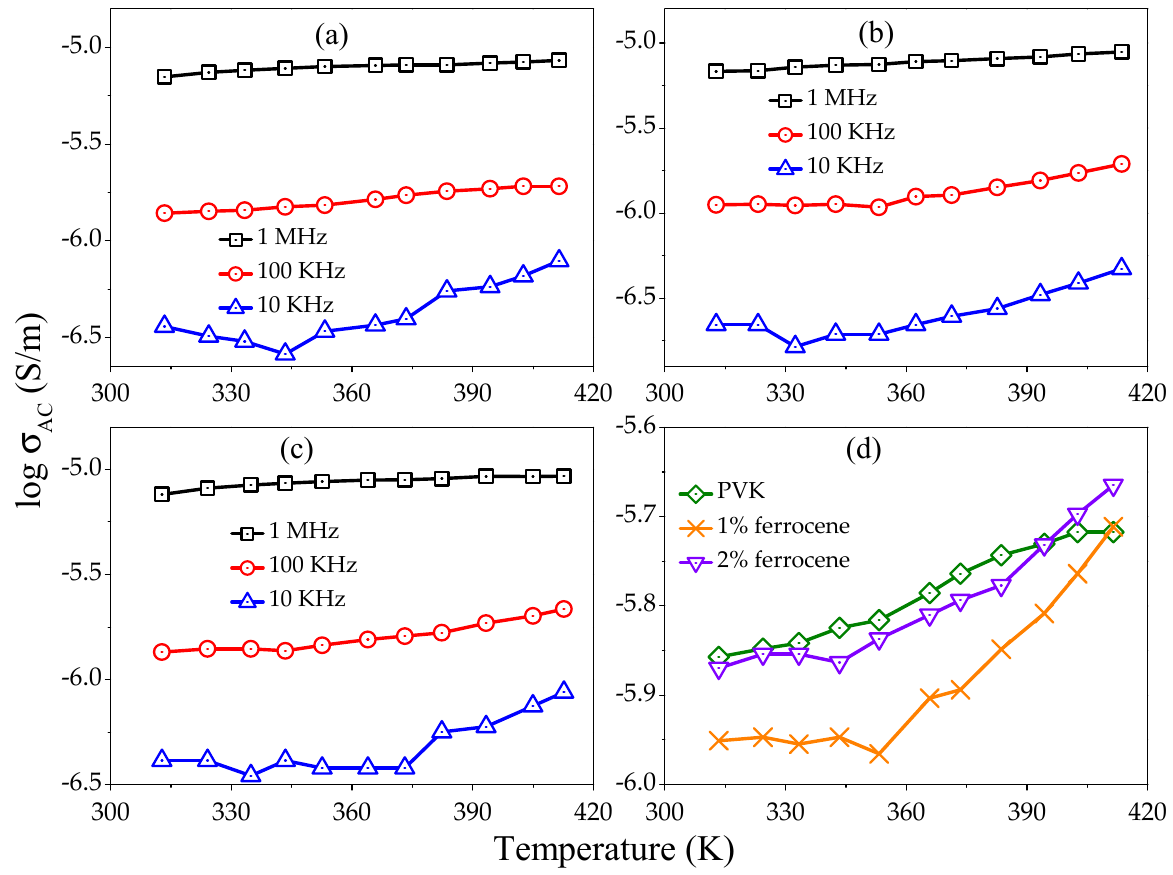
Figure 7. Relationship between AC conductivity and temperature at different frequencies in case of ( a ) pure PVK, ( b ) 1% ferrocene doped PVK, ( c ) 2% ferrocene doped PVK, and ( d ) comparison of AC conductivity of PVK and doped PVK at frequency of 100 kHz.